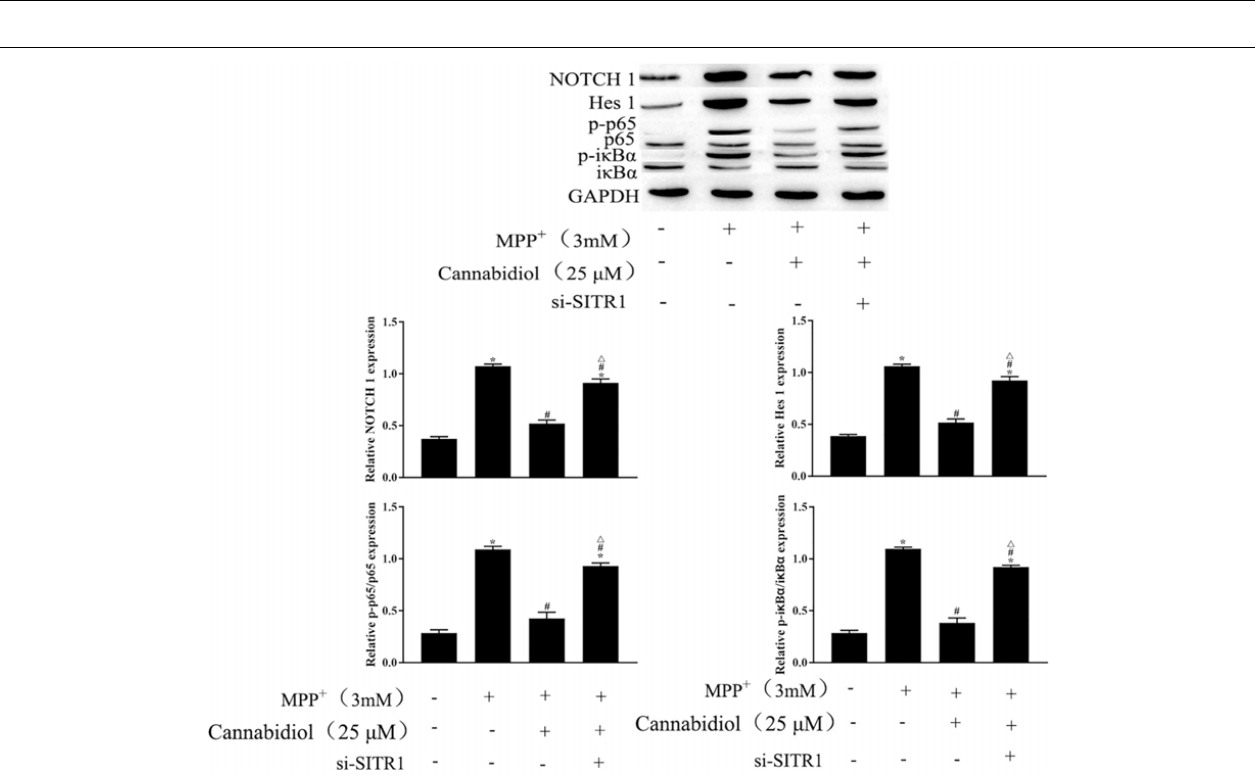
FIGURE 6 | Cannabidiol inhibits NF- κ B and NOTCH pathways by upregulating SIRT1. The expression of p65, NOTCH in SH-SY5Y cells were measured by western blotting; ∗ p < 0.05, compared with the control group, # p < 0.05 compared with MPP + alone, (cid:77) p < 0.05 compared with MPP + + Cannabidiol.